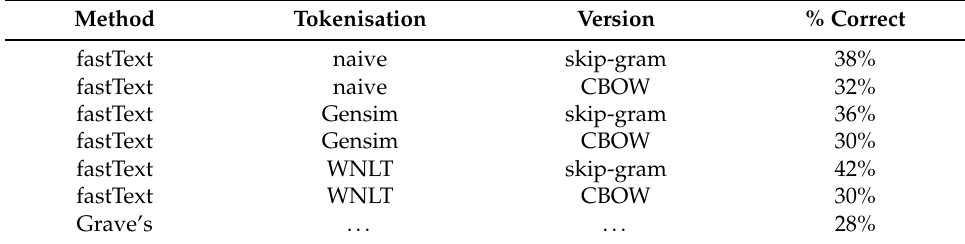
Table 5. The results achieved on the synonymy detection